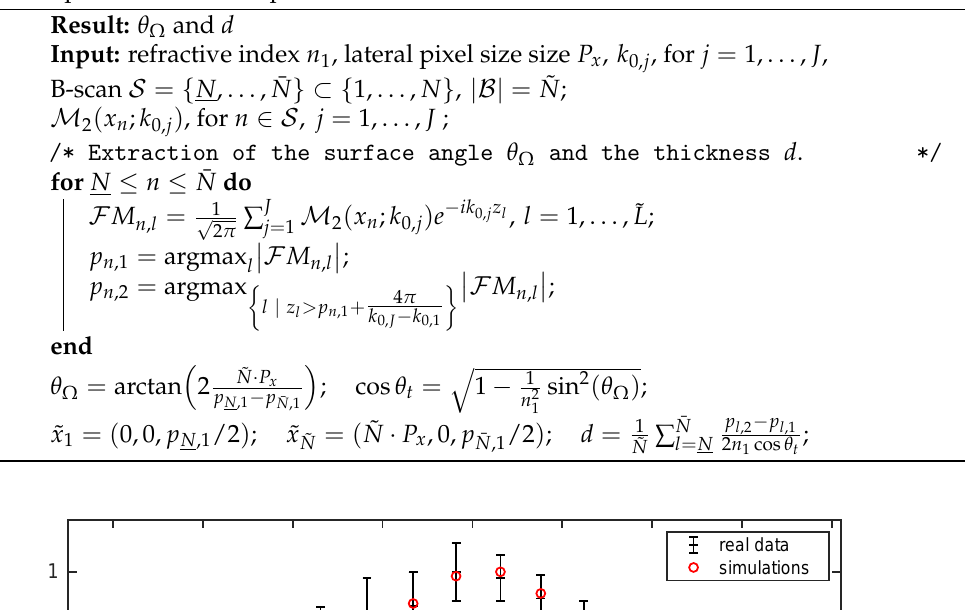
Algorithm 2: Extraction scheme for the tilting angle θ Ω and the thickness d from the power vs. focus experiment.